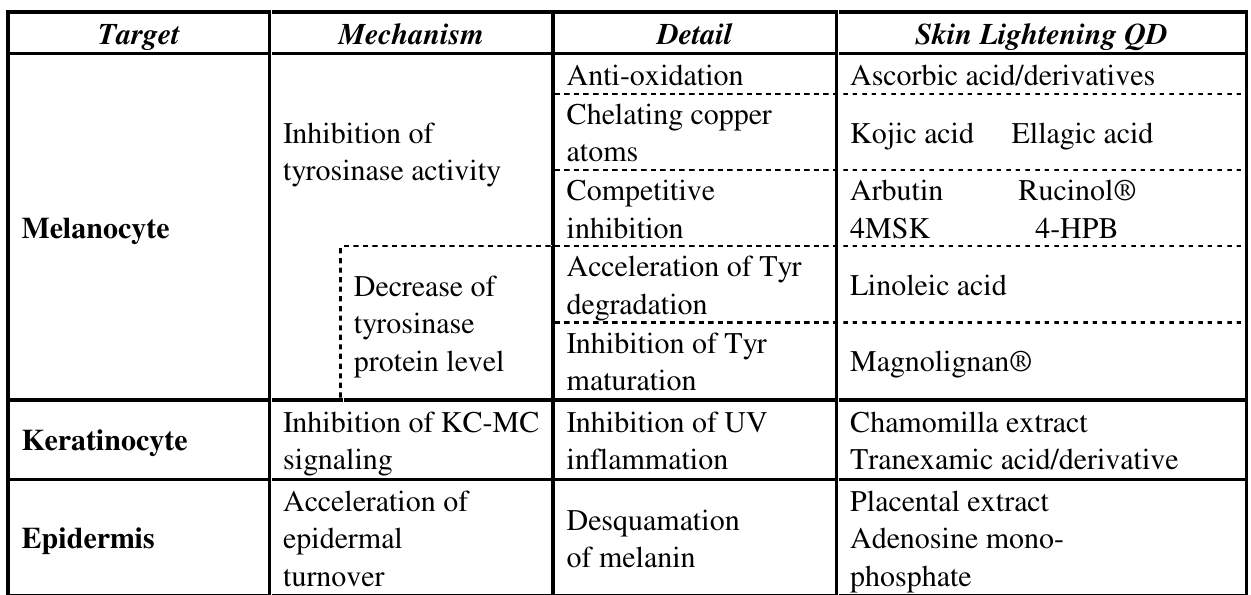
Table 1. Mechanistic classification of skin lightening QDs approved by the MHLW of